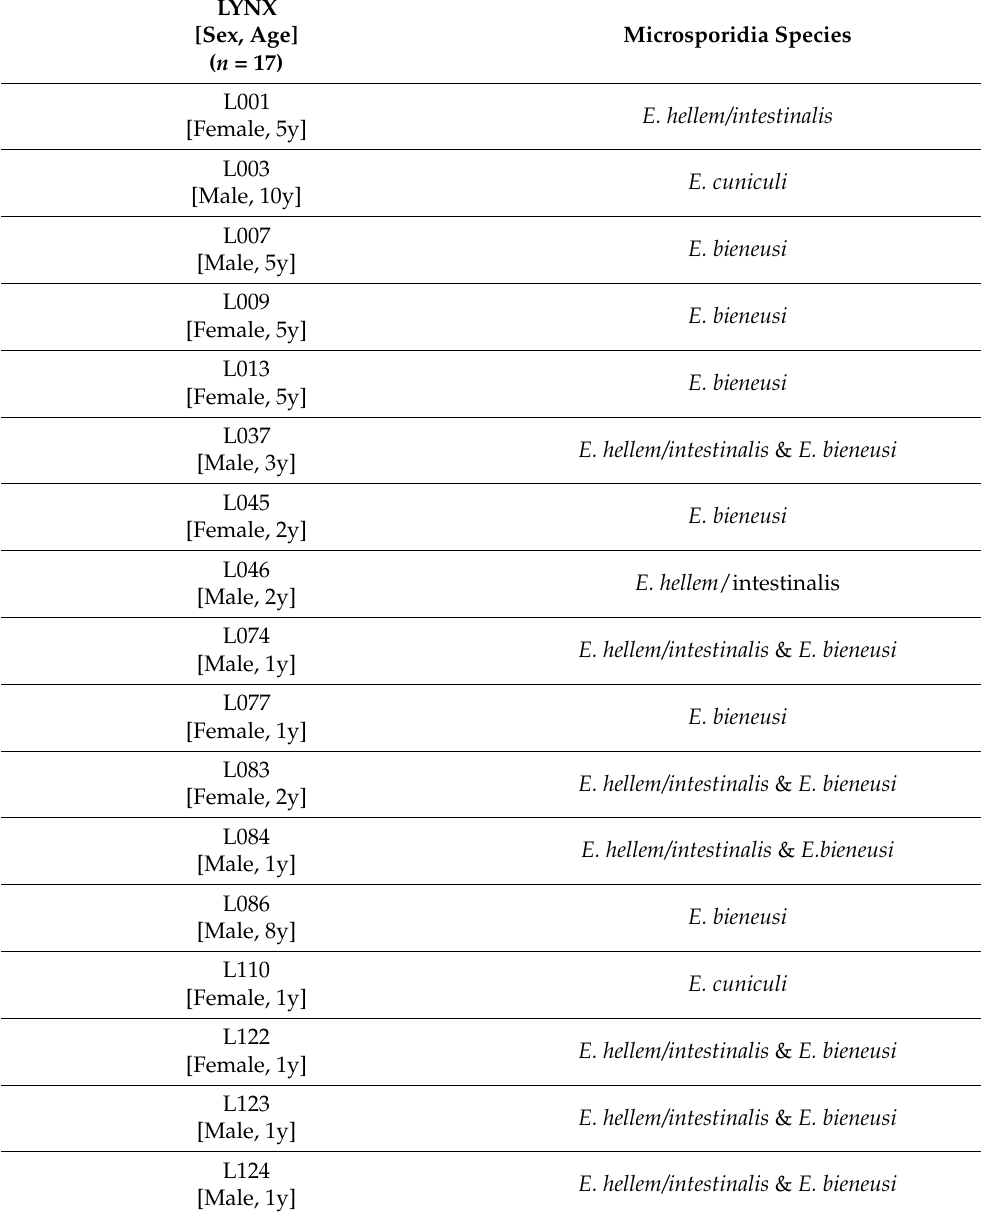
Table 2. Microsporidia species in lynx feces samples identified by Real-Time